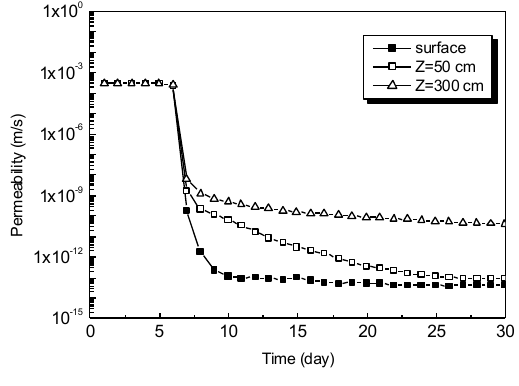
Figure 7c. Variation of the soil permeability Fig. 7c. Variation of the soil permeability.